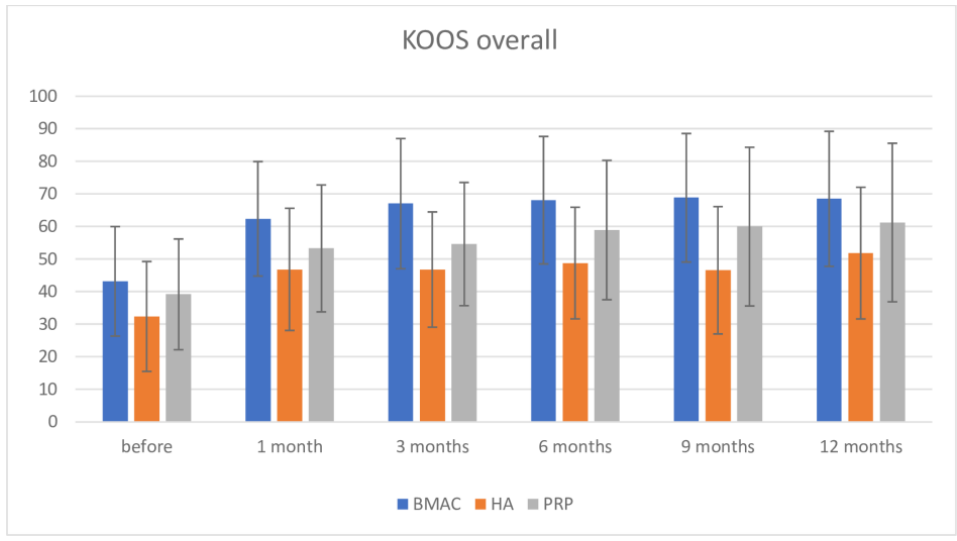
Figure 3. KOOS overall scale before intervention and after 1, 3, 6, 9, and 12 months.